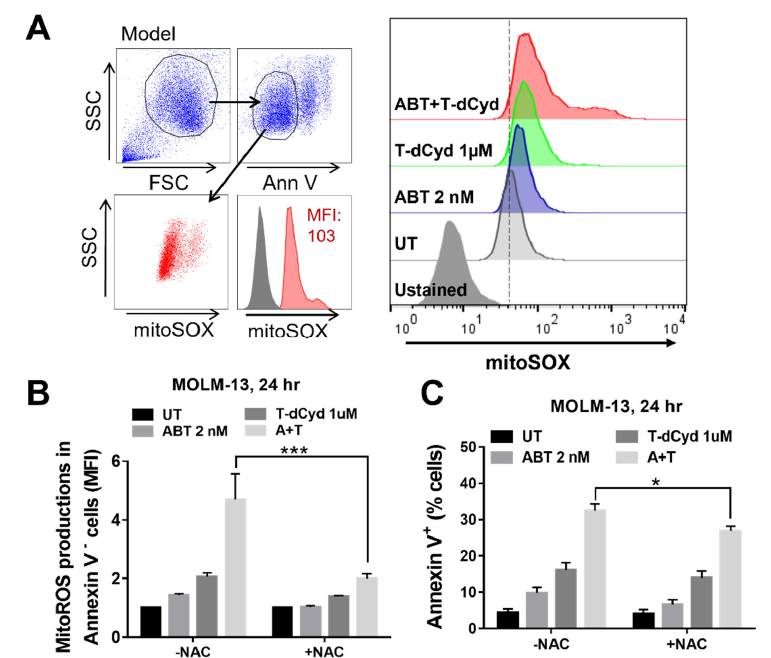
Figure 3. Bone marrow cells from an MDS patient (MDS-EB-1) were exposed (24 h) to 500 nM T-dCyd with or without 50 nM venetoclax, after which they were stained with PE-CD34 + (red) and Annexin (green) Abs. Cells were then viewed under an immunofluorescence microscope at 200× magnification ( A ). Cleaved PARP was detected by WB ( B ). Cord blood normal CD34 + cells ( n = 4) were exposed (24 h) to 1 uM T-dCyd with or without 50 nM venetoclax, after which the CD34 + gated population was monitored for cell viability using Annexin V and 7-AAD staining ( C ). The percentage of viable cells in control and treated populations is reflected in the dot plot ( D ).